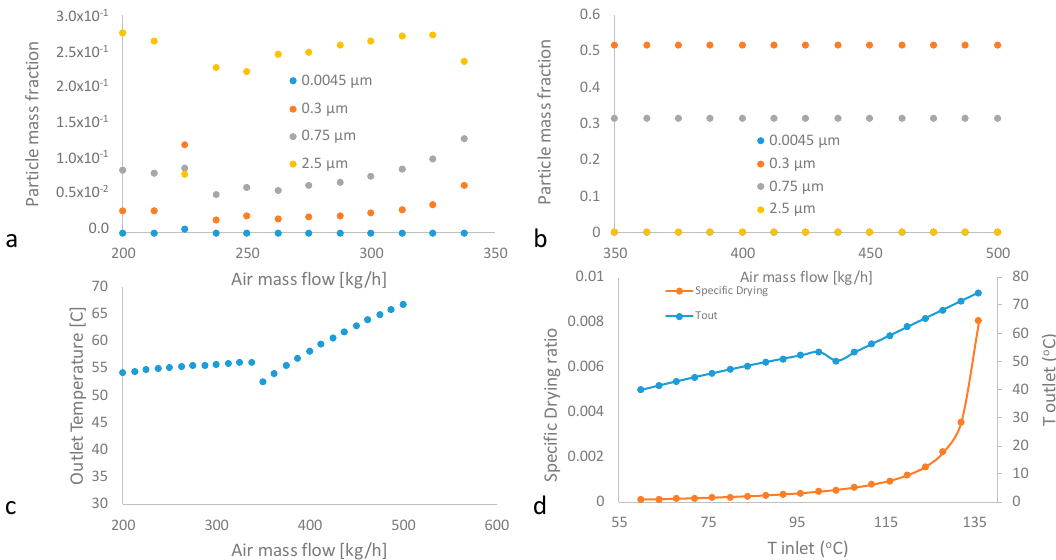
Figure 16. Sensitivity analysis of: ( a , b ) particle mass fraction dependence on different ranges of air mass flow, ( c ) outlet temperature dependence on air mass flow and ( d ) specific drying ratio dependence on inlet temperature.